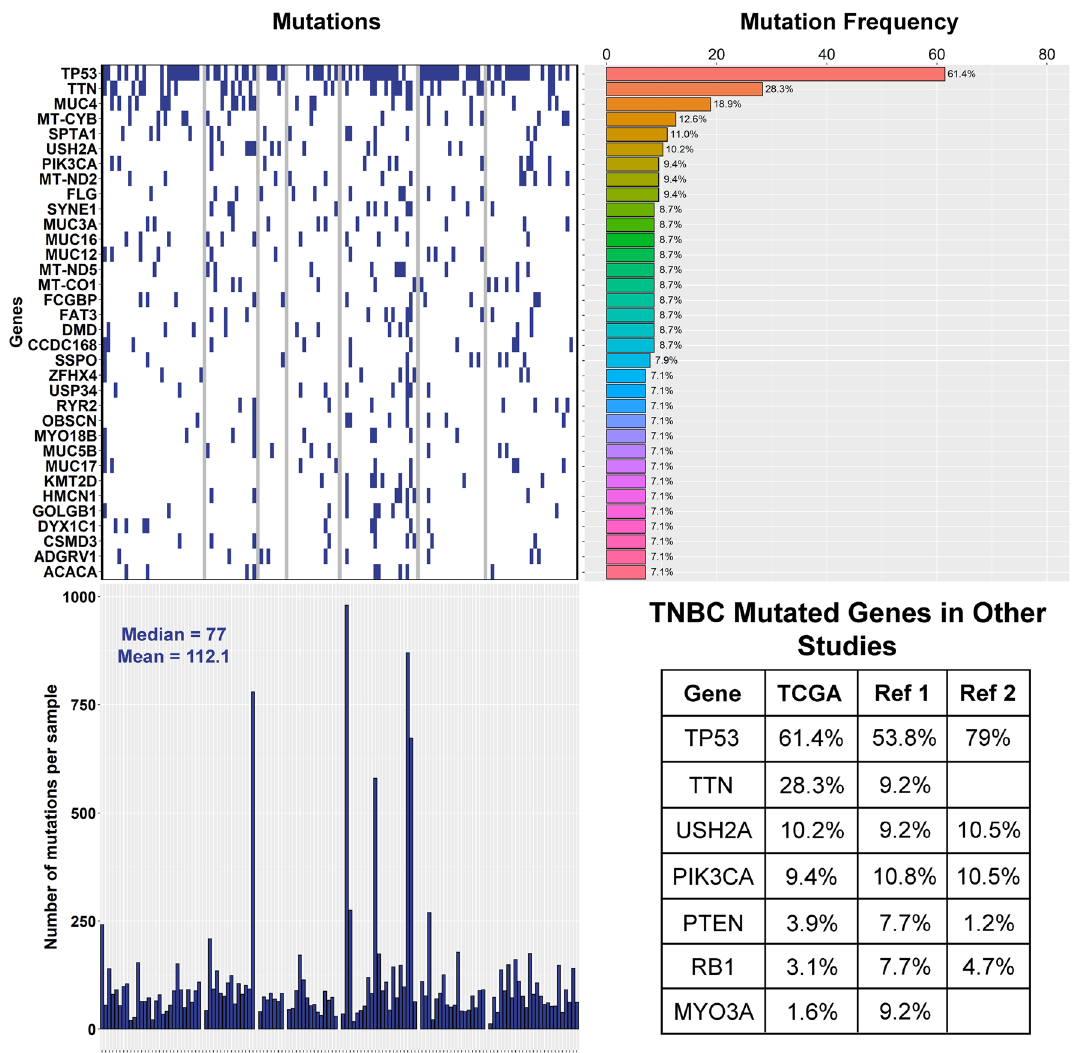
Figure 8. Top 34 gene mutations in TCGA TNBC cases. (Top left and right) Mutational analysis of the TNBC cases in TCGA identifies TP53 (61.4%), TTN (28.3%), MUC4 (18.9%), MT-CYB (12.6%), SPTA1 (11%), and USH2A (10.2%) as the most frequently mutated genes. (Bottom left) Median and mean mutation count are 77 and 112.1, respectively. (Bottom right) Mutation frequencies of several genes in TNBC as determined by this study (TCGA) or other whole genome or exome sequencing studies (Ref 1 = 37 , Ref 2 = 38 ). (Top left and right, Bottom left) Images generated with R 4.0.2 (https ://www.R-proje ct.org) 35 . (Bottom right) Image generated with Adobe Photoshop CC 2018 (https ://www.adobe